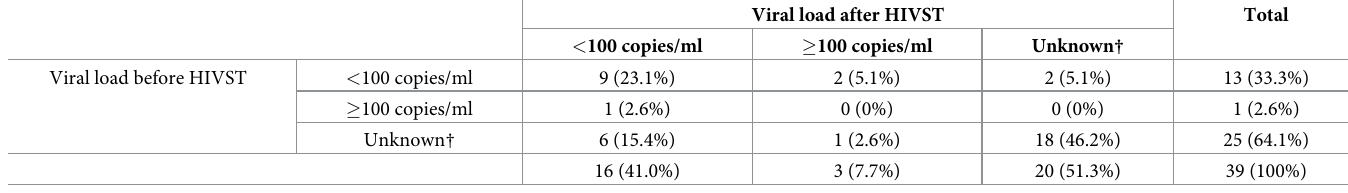
Table 4. Viral load testing and viral load suppression in the 12 months before and after HIVST among PLHIV who tested with HIVST (N =